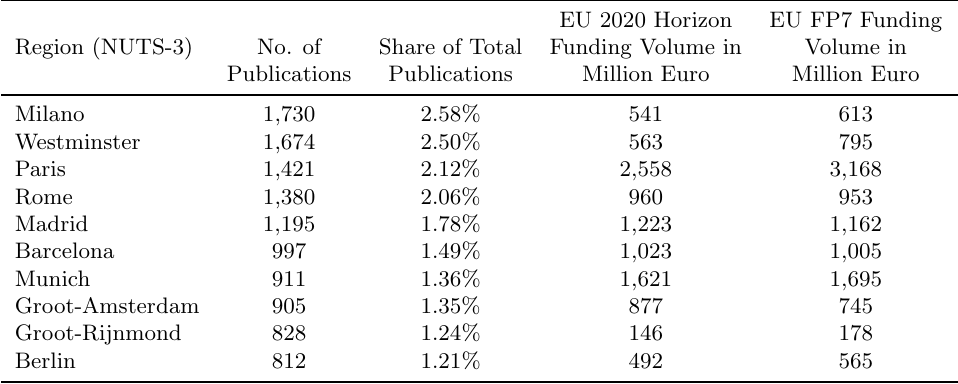
Table 1a: The ten Most Active Regions in Cardiovascular Device Knowledge Output by number of publications, 2014-2017